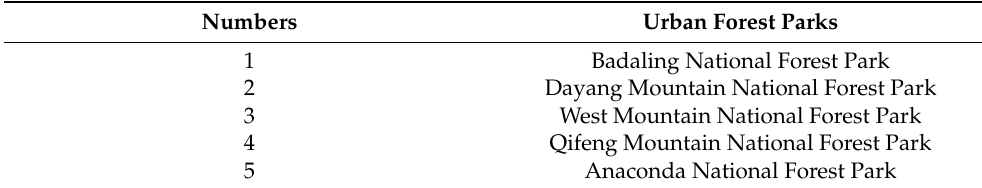
Table 1. The details of the selected urban forest parks.